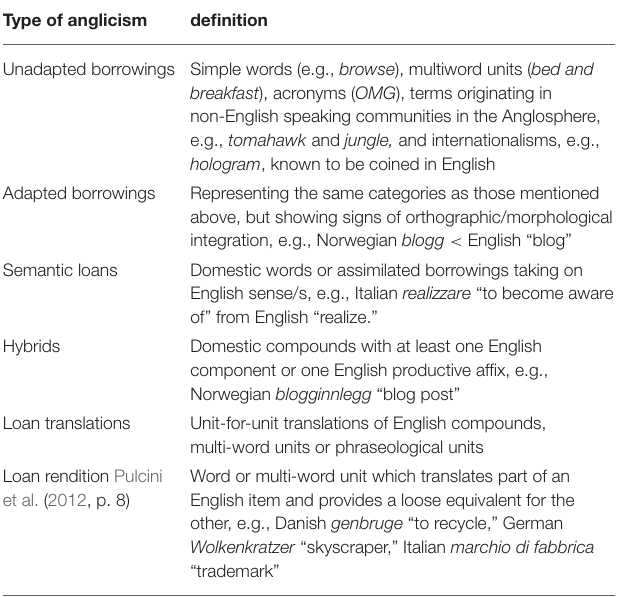
TABLE 1 | Typology of anglicisms, adapted from Pulcini et al. (2012, p. 8) and Gottlieb et al. (2018, p. 7). Type of